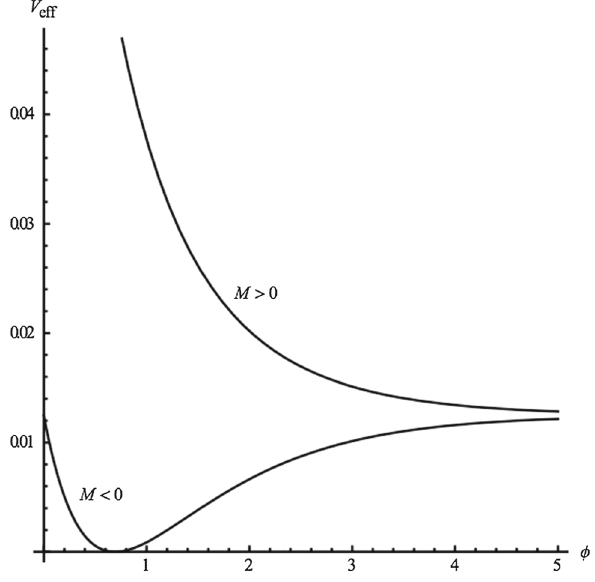
Fig. 1 Graph of V eff for M > 0 and M < 0. The minimum appears for the graph M <